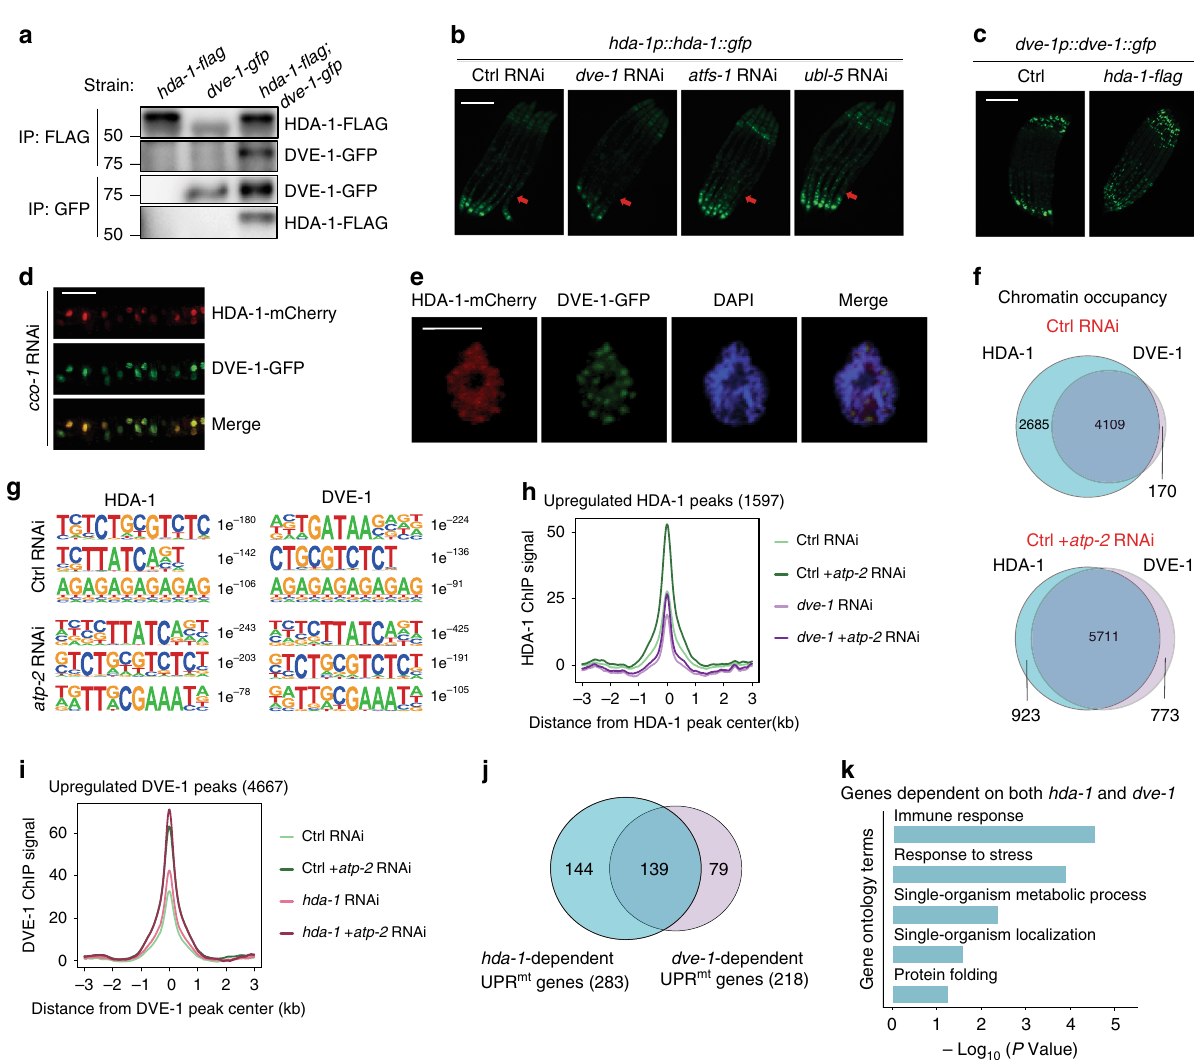
Fig. 2 HDA-1 interacts with DVE-1 to regulate UPR mt . a Immunoprecipitation followed by immunoblotting reveals that HDA-1 interacts with DVE-1 in worms. b Representative fl uorescence images of hda-1p::hda-1::gfp worms. Worms were fed with control, dve-1 , atfs-1 , or ubl-5 RNAi. Images were taken when animals reached young adult stage. Red arrows indicate the posterior region of the intestine where hda-1p::hda-1::gfp is induced or suppressed. Scale bar, 200 µ m. c Representative fl uorescence images of dve-1p::dve-1::gfp worms, without (control) or with over-expression of hda-1p::hda-1:: fl ag . Scale bar, 200 µ m. d , e Representative fl uorescence images of hda-1p::hda-1::mCherry; dve-1p::dve-1::gfp worms. Worms were fed with cco-1 RNAi from L1 stage and imaged on day 1 of adulthood. d Fluorescence images show the bottom part of the intestine. Scale bar, 50 µ m. e Fluorescence images reveal the nucleus of an intestinal cell. Scale bar, 5 µ m. f Venn diagram showing overlap between HDA-1 (blue) and DVE-1 (purple) ChlP peaks in worms fed on control or atp-2 RNAi. g Nucleotide binding motifs of HDA-1 and DVE-1 in the presence or absence of mitochondrial stress. The P values of the motifs are also shown. h Analysis of HDA-1 ChIP peak signals in control worms or dve-1 RNAi worms in the presence or absence of atp-2 RNAi-induced mitochondrial stress. i Analysis of DVE-1 ChIP peak signals in control worms or hda-1 RNAi worms in the presence or absence of atp-2 RNAi-induced mitochondrial stress. j Venn diagram comparing genes upregulated in response to mitochondrial perturbation that are dependent on hda-1 (blue) or dve-1 (purple). k GO term analysis of UPR mt -upregulated genes that are dependent on both hda-1 and dve-1 . P values are DAVID modi fi ed Fisher exact P values, one-sided. Source data are provided as a Source Data fi